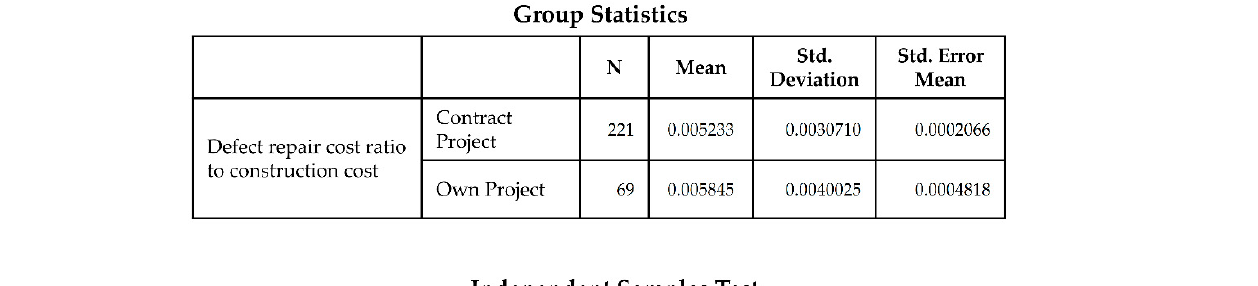
Figure A3. ANOVA result of project implementation type.